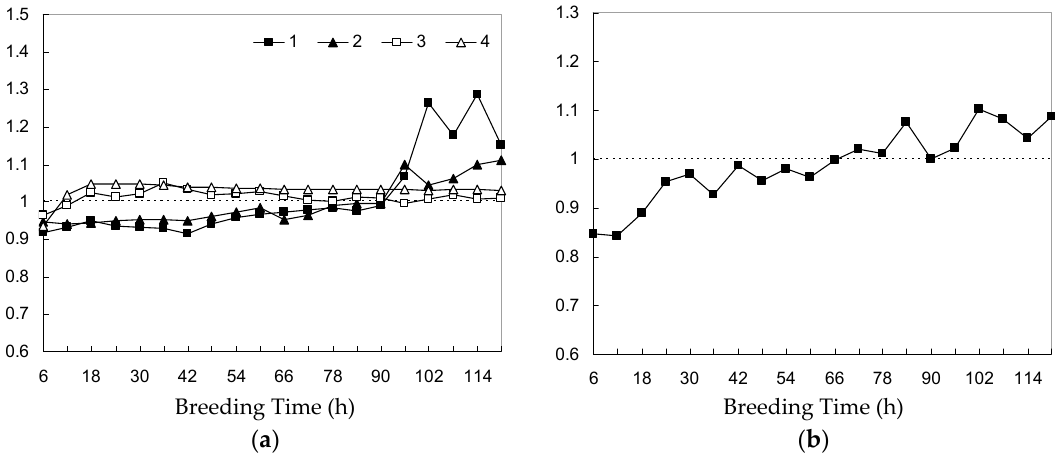
Figure 5. As Figure 4, but for land surface variables. ( a ) Soil moisture (SMO), ( b ) skin temperature (TSK).